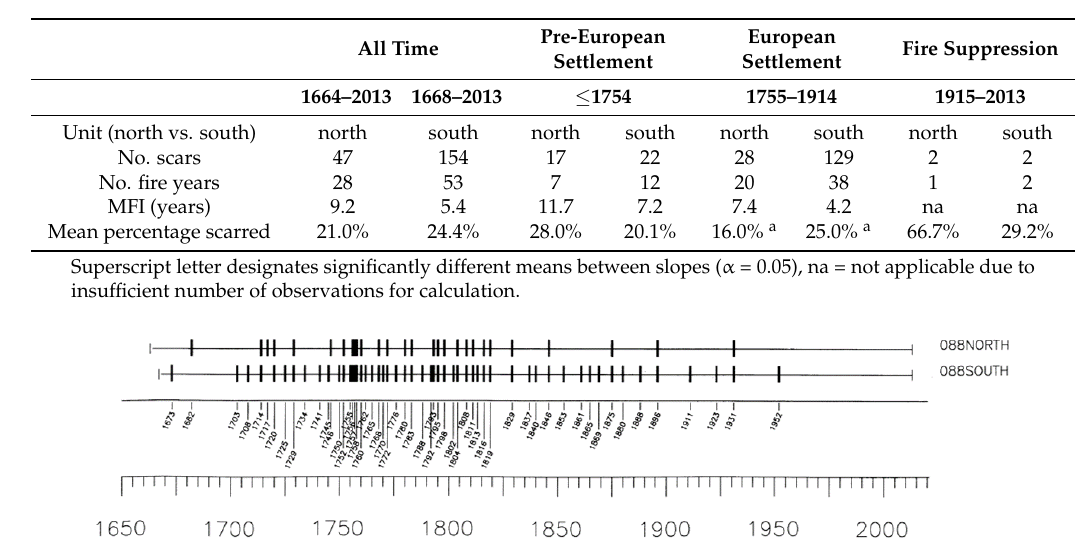
Table 3. Fire-scarring characteristics for samples on the north-facing versus south-facing slopes of Tuscarora Mountain at SGL 088.